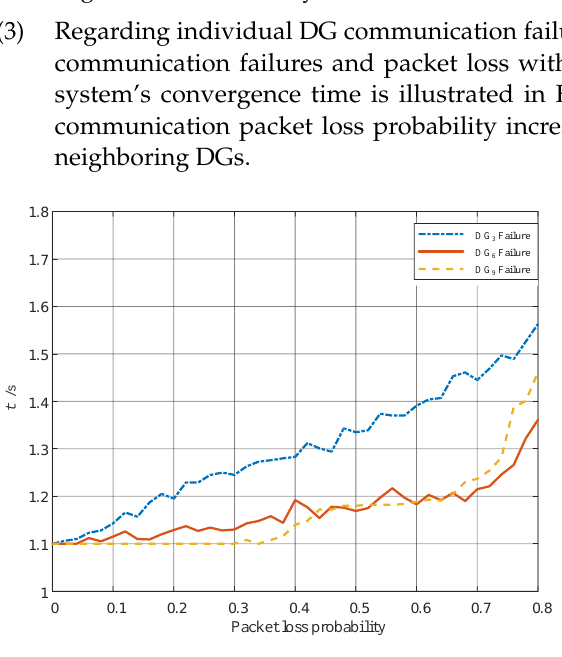
Figure 11. System convergence time for DG 3 , DG 6 , and DG 9